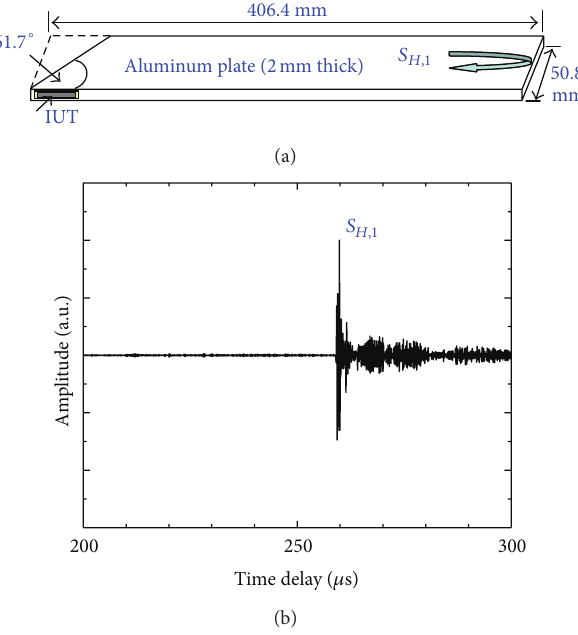
Figure 15: Schematic diagram of an IUT fabricated directly onto the side edge of a 2 mm thick aluminum plate to generate and detect SH PAWs (a) and a received echo signal (b).